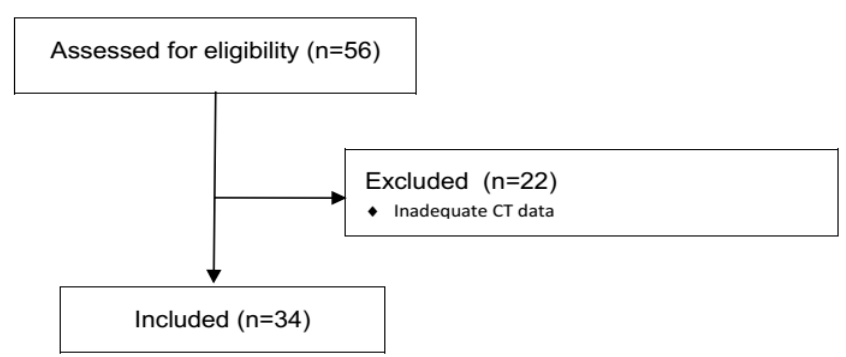
Figure 7. CONSORT Diagram describing the population of the study.